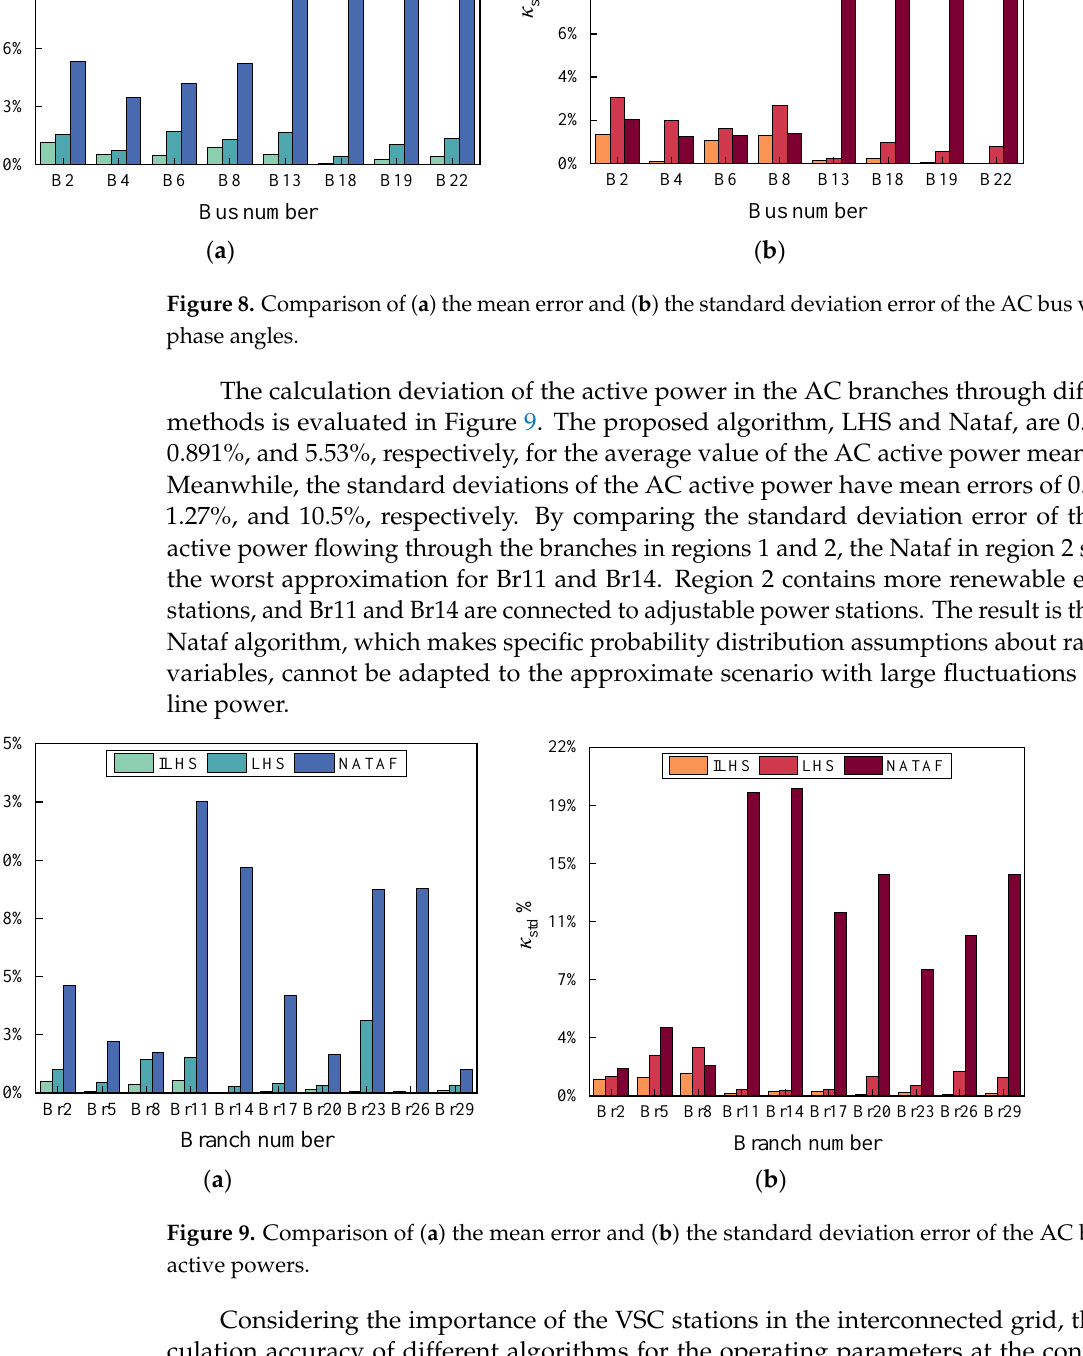
Table 2. The mean and standard deviation errors of the parameters at the VSC stations.